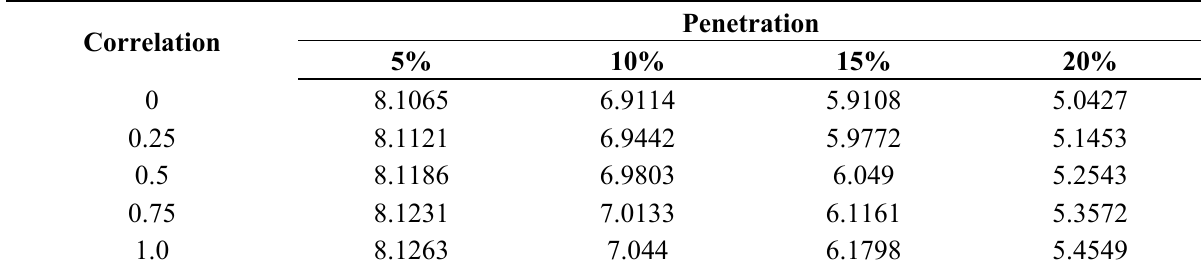
Table 1. LOLE values for RTS varying correlation and